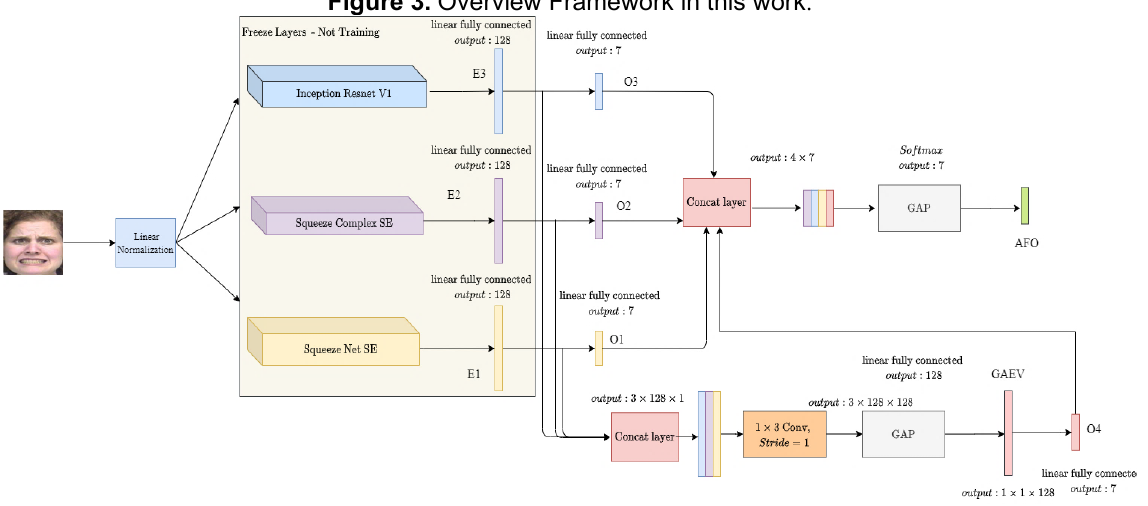
Figure 3. Overview Framework in this work .